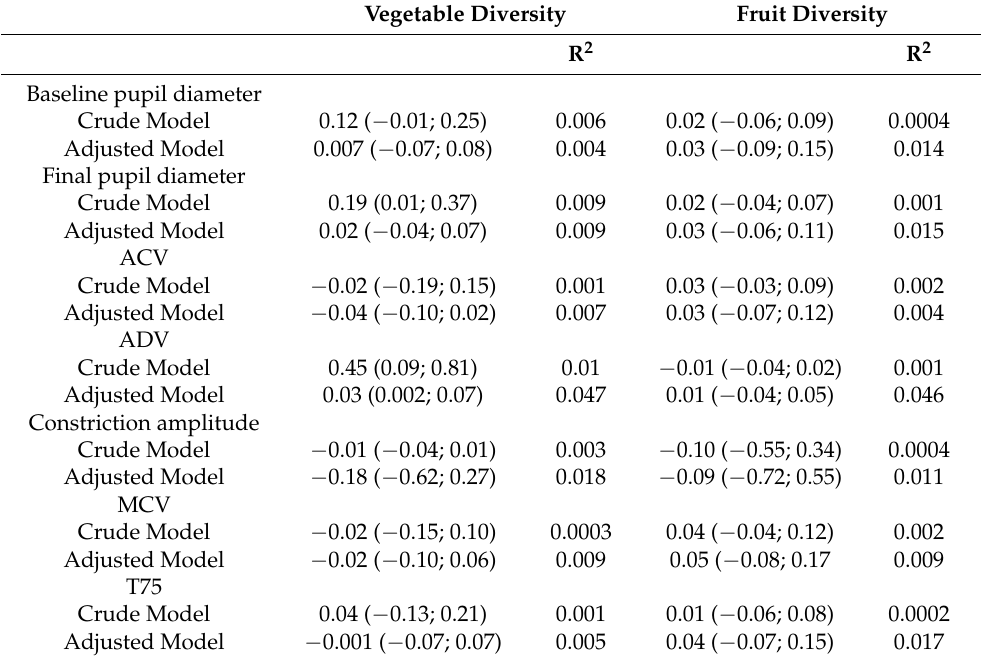
Baseline pupil diameter: initial diameter of the pupil before. Final pupil diameter: diameter of the pupil at constriction peak. ACV: average constriction velocity. ADV: average dilation velocity; relative constriction amplitude. MCV: maximum constriction velocity. T75: total time taken by the pupil to recover to 75% of the initial resting pupil size after reaching peak of constriction. Adjusted model: adjusted for sex, age, body